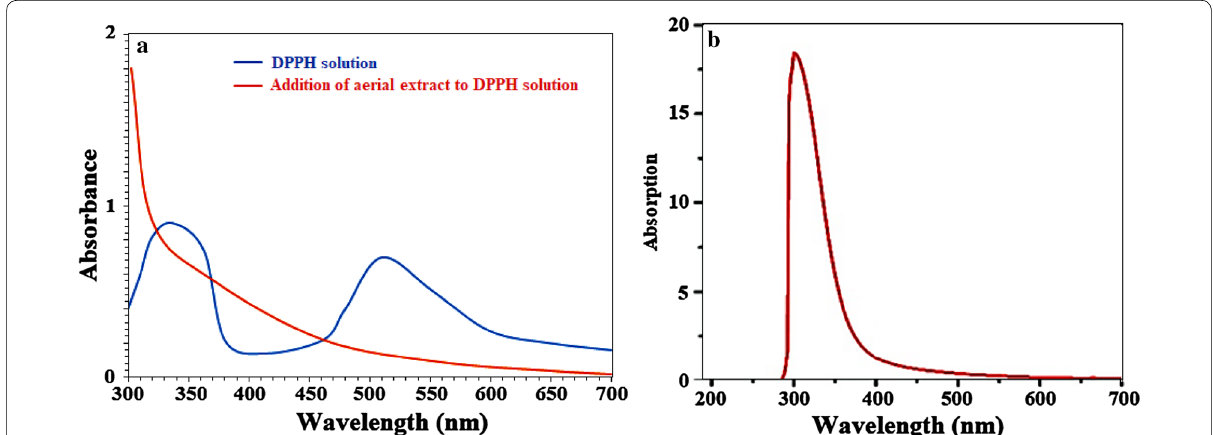
Fig. 7 a Antiradical activity of the aerial extract of C. heratensis (0.1 g/mL) over quenching 2,2 ′ -diphenylpicryl-1-hydrazyl (DPPH) radicals at room temperature. b UV–visible spectra of aerial part of C. heratensis